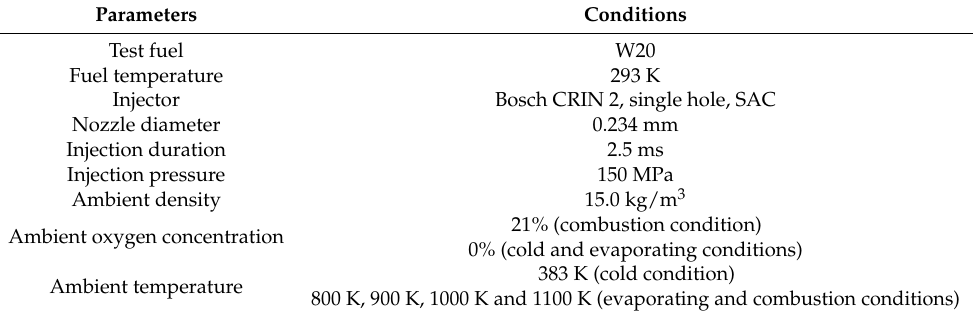
Table 2. Experimental